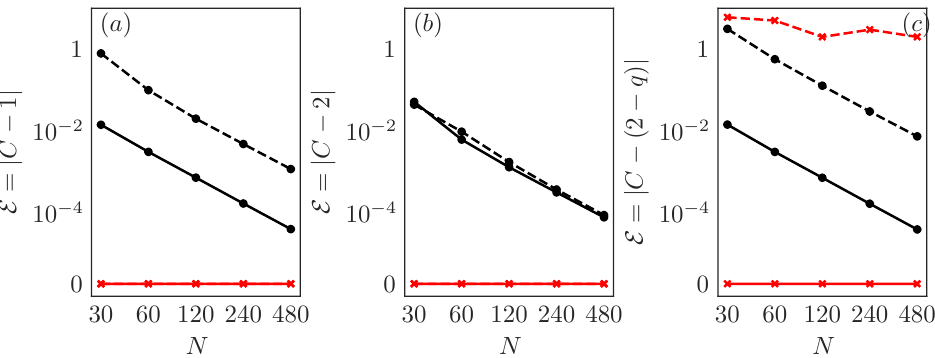
Figure 7: Approximation error in Chern number computation. Panel (a) shows E the residual in the Chern number computation for the lowest band of the standard HH model [ C = 1 ] . Panels ( b ) , ( c ) show the same for the dark state Chern number. = 2 for b = 1 and b = q . and for panel ( c ) : C In ( b ) : C D 1 2 = ( q + 1 ) / 2. The curve markings are common and refer to , brute-force and b 2 discretization method, q = 3, brute-force discretization method, q = 11, Fukui method, q = 3 and Fukui method, q =